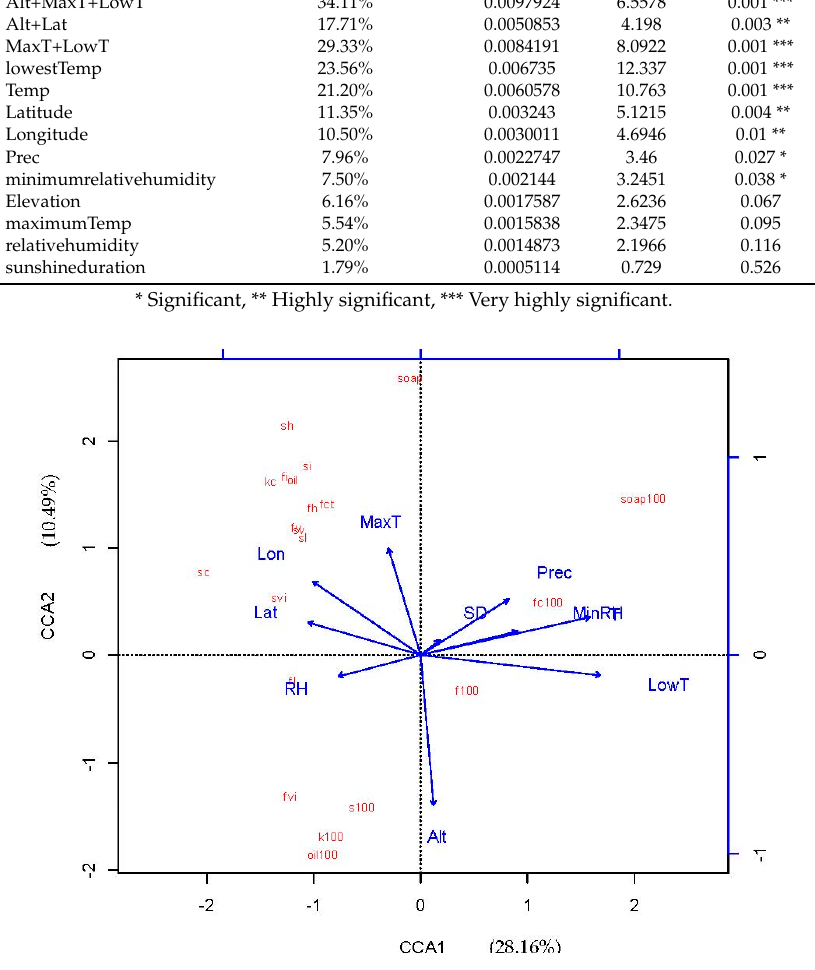
Figure 2. CCA ordination diagram of Sapindus mukorossi seed and fruit traits, and environmental factors.